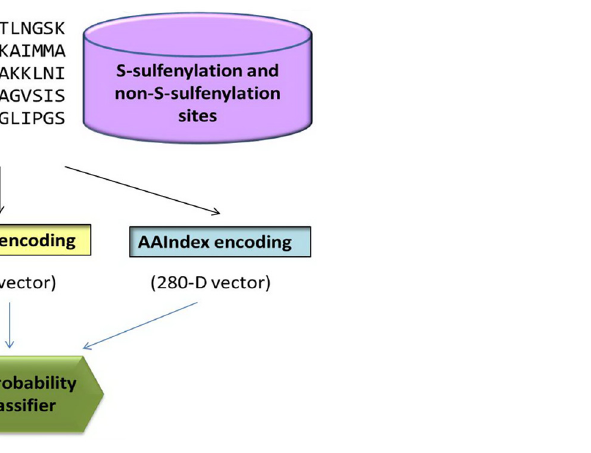
Fig 1. A diagram flow to illustrate the predicting procedure.